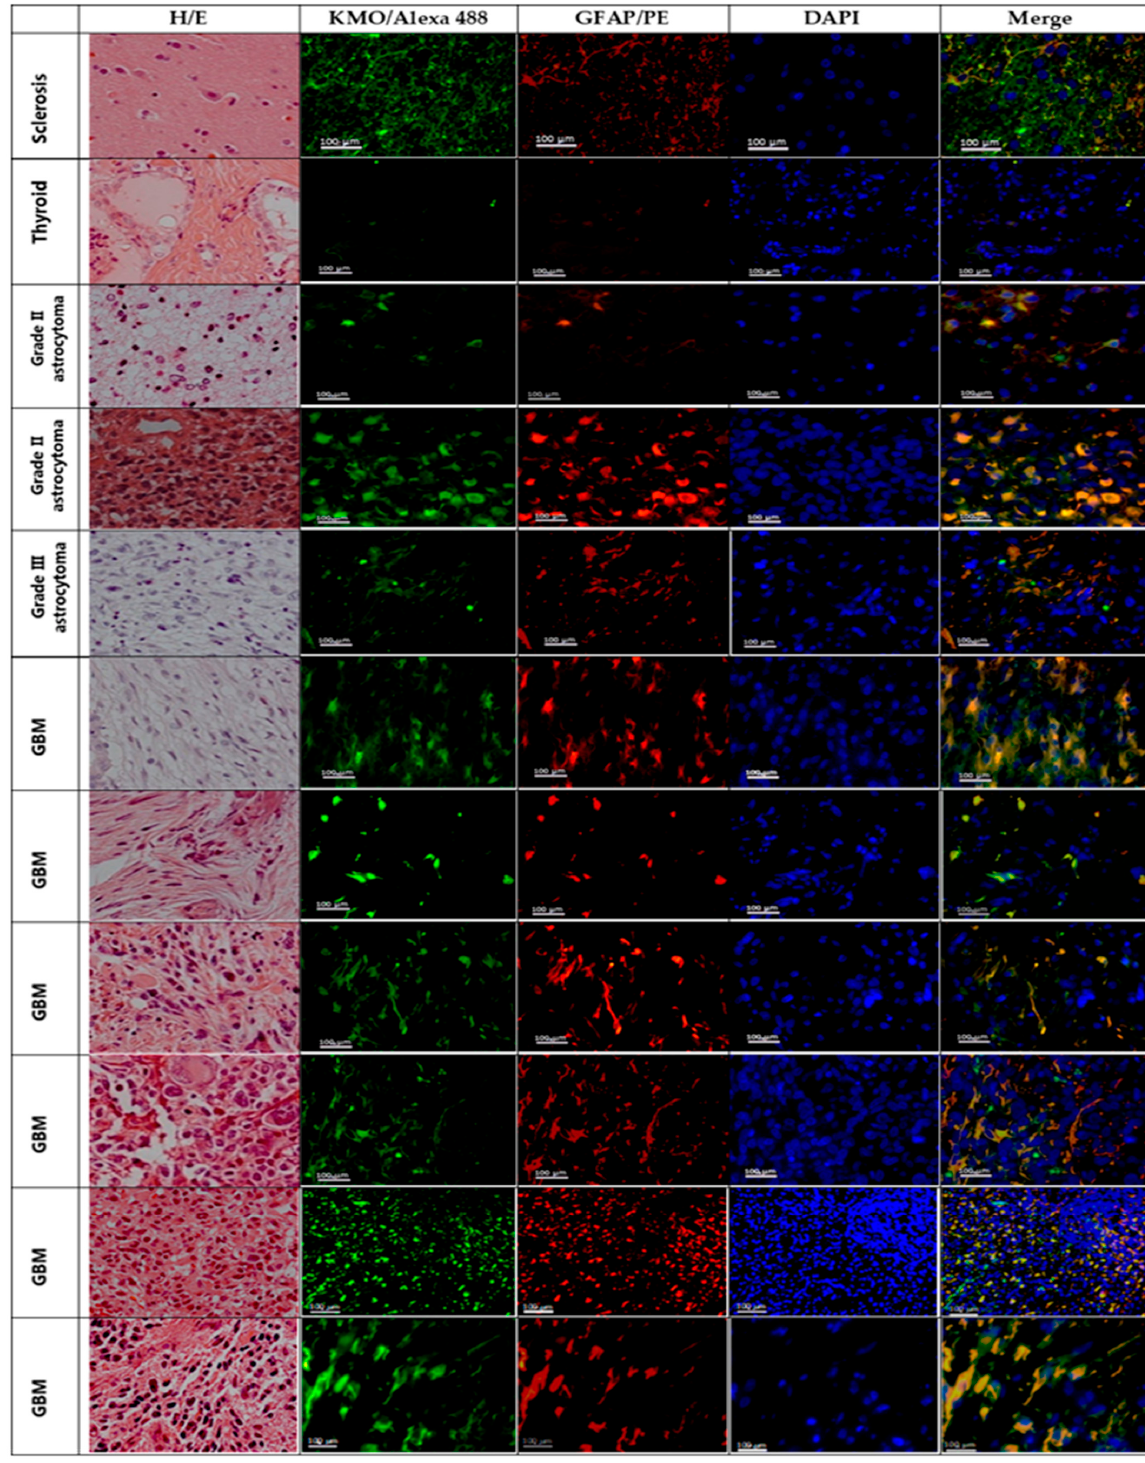
Figure 4. KMO in astrocytoma malignant cells. Representative images of hematoxylin/eosin (H/E) staining and immunofluorescence staining for KMO (KMO/Alexa Fluor 488; green), astrocytes or astrocytoma cells (GFAP/PE; red); and nuclei (DAPI; blue) in tissue samples from patients diagnosed with mesial sclerosis (line 1), thyroid carcinoma (line 2), and astrocytoma (lines 3–10). Images were acquired at 40 × magnification. Scale bars represent 100 µ